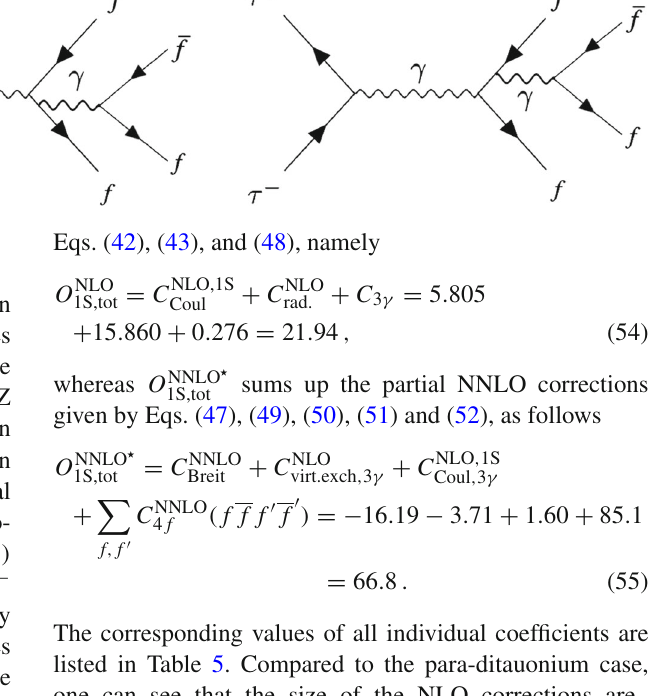
Fig. 7 Representative Feynman diagrams of (real NNLO) ortho-ditauonium decays into four